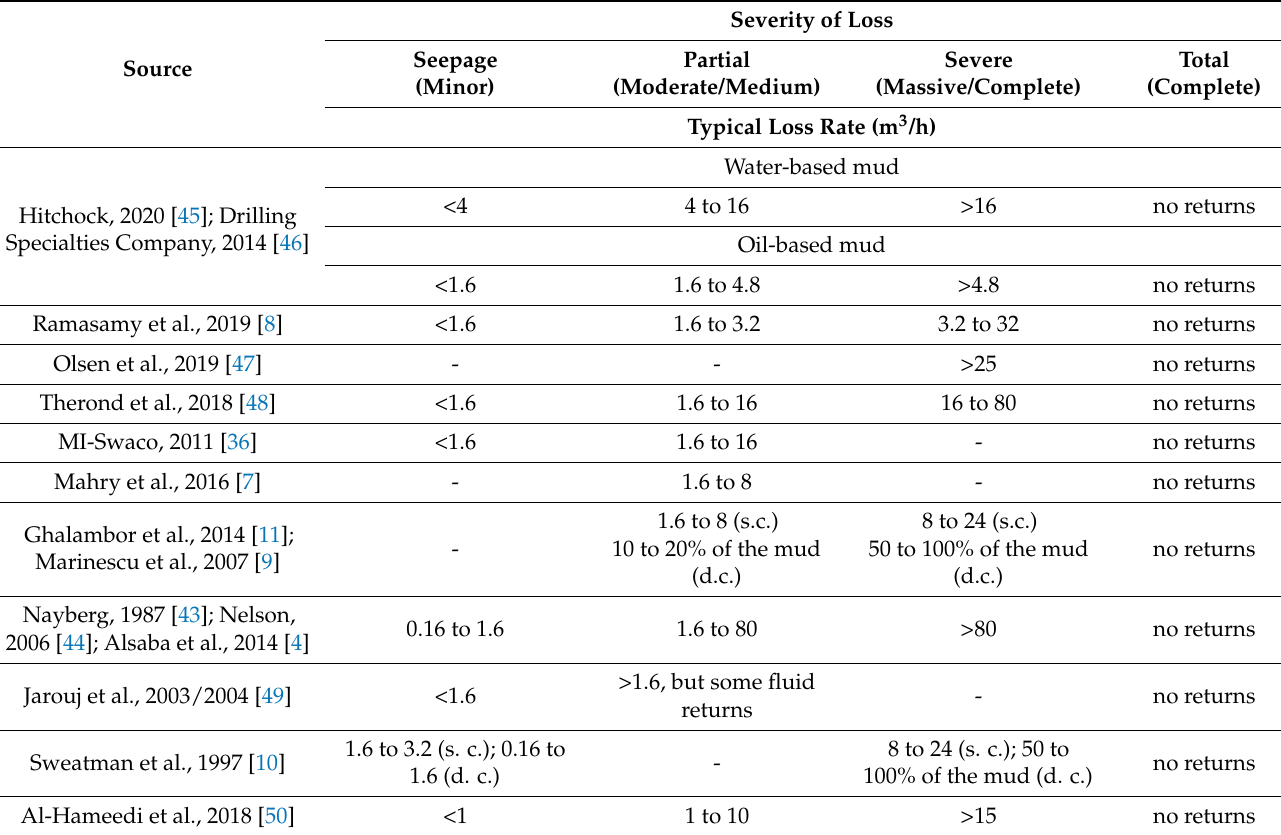
Table 3. Classification of losses according to different authors and